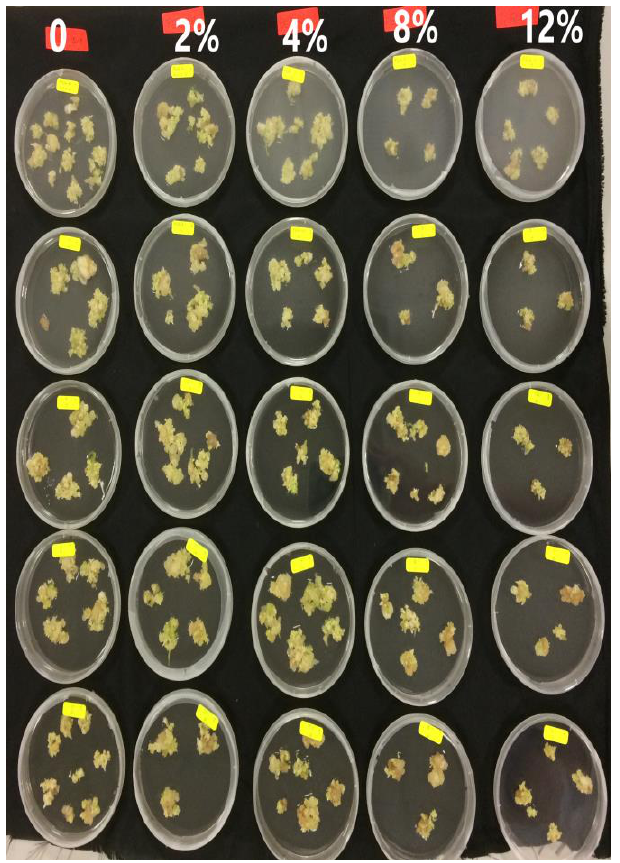
Figure 5. Embryogenic callus after 6 weeks on maturation media supplemented with different concentrations of polyethylene glycol 8000 (PEG) (0, 2, 4, 8, 12%) (M1–M5).